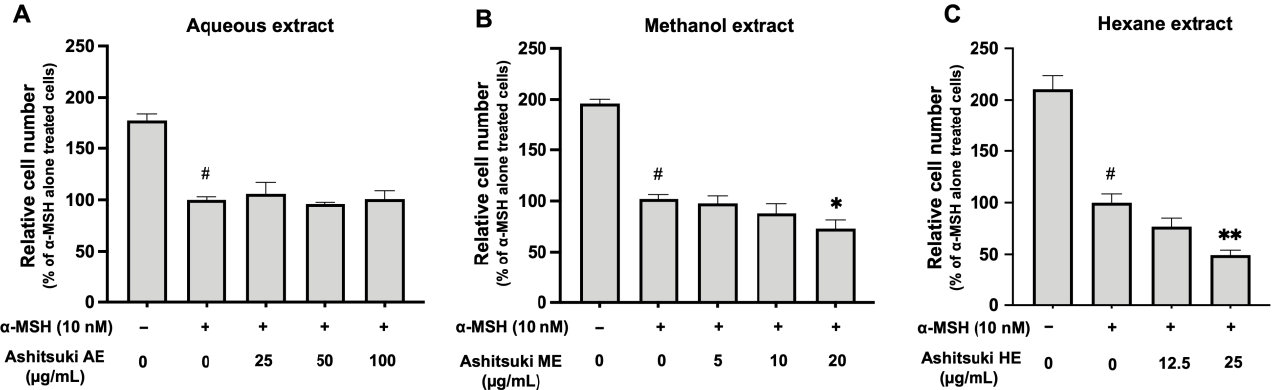
Figure 5. Effect of N. verrucosum ( ashitsuki ) extracts on the proliferation of B16F1 melanoma cells. B16F1 melanoma cells were treated with N. verrucosum aqueous ( A ), methanol ( B ), and hexane ( C ) extract for 3 d, in the presence of 10 nM α -melanocyte-stimulating hormone ( α -MSH). After treatment, the trypan blue exclusion test was performed, and the cell proliferation rate was assessed. Results are represented as a percentage of the α -MSH-alone-treated control group; the data are shown as mean ± SEM of three separate experiments. # p < 0.05 versus the control group. * p < 0.05, ** p < 0.01 versus the α -MSH-alone-treated control group.